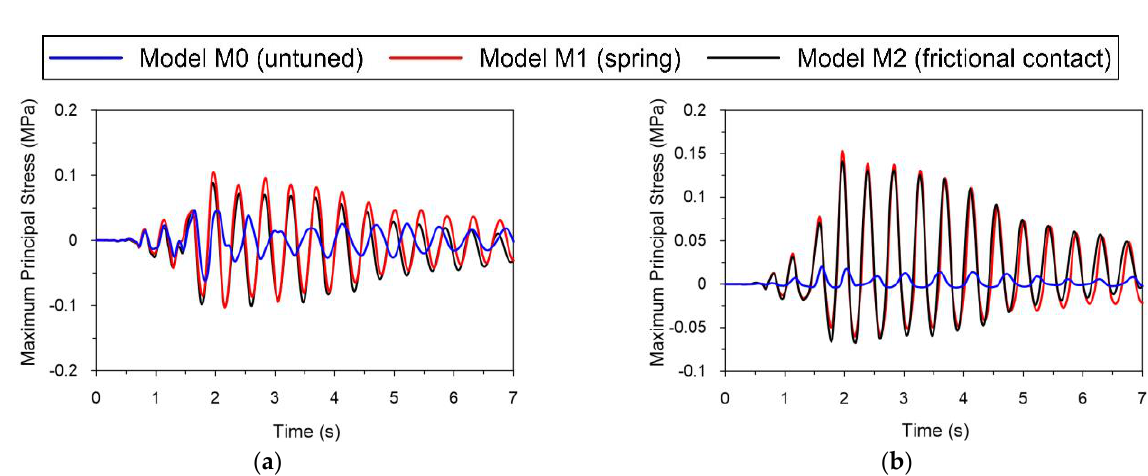
Figure 18. Comparison of stress-time histories of maximal principal stresses obtained for three models of the bridge subjected to the low-intensity tremor (D_0) at elements: ( a ) S1 (in the middle of the longest span); ( b ) 3B (above the transversely sliding bearing).